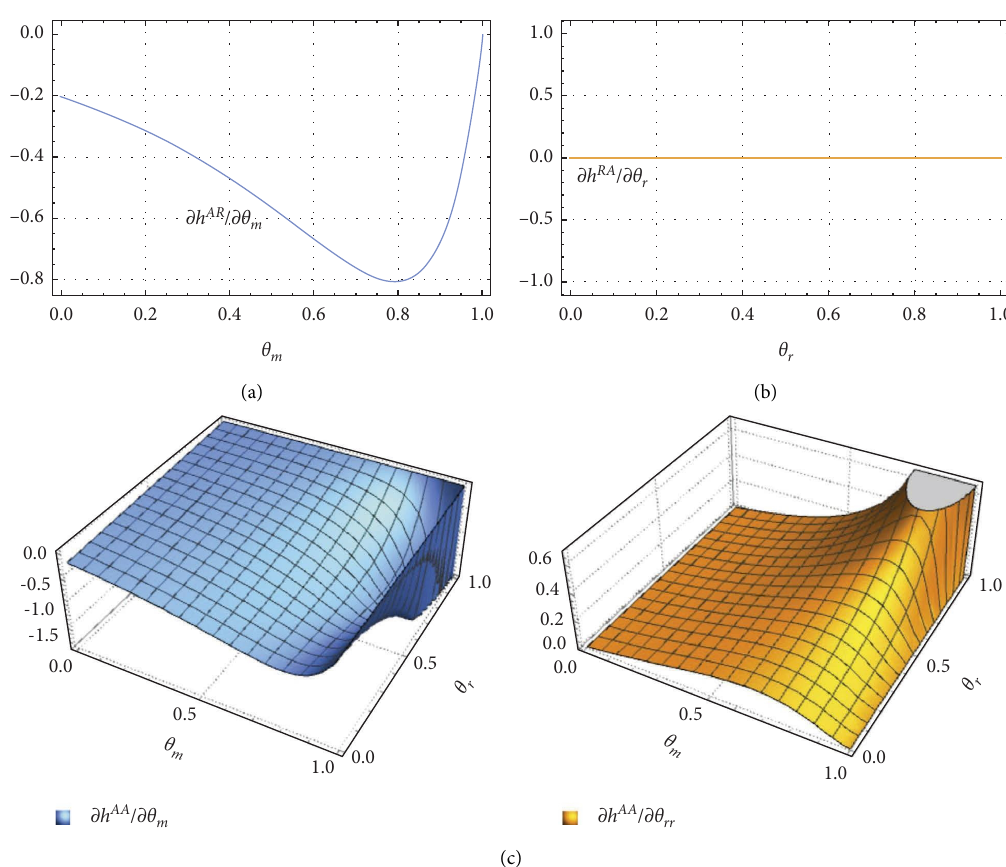
Figure 7: Infuence of diferent members’ altruistic preferences on the range of strategic inventory ( a � 1 ,b � 0 . 5 ,c � 0 . 2 , c � 1 ) . (a) Only the manufacturer is altruistic. (b) Only the retailer is altruistic. (c) Both members are altruistic. Table 6: Infuence of the retailer’s altruistic preference on decisions.